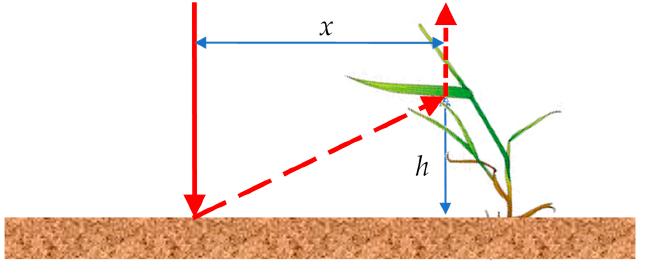
Figure 12. The geometry for secondary